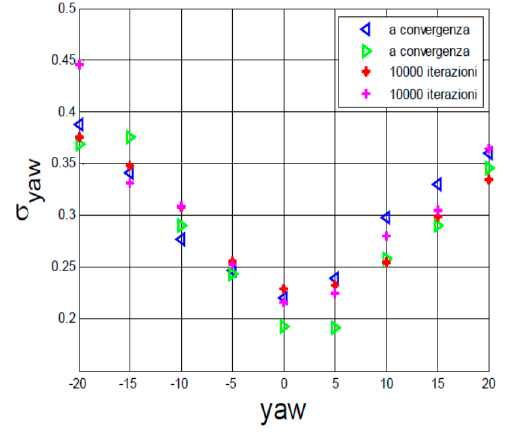
Figure 14. Results in terms of standard deviation for different runs. Table 1. Averaged errors ( δ ) for the Yaw, Mach, total and static pressure.